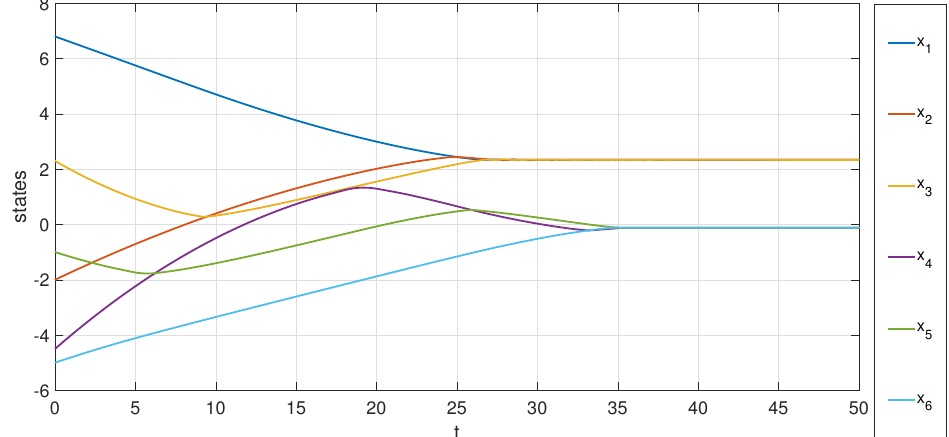
Figure 10. Simulation results relating to topology Figure 7.